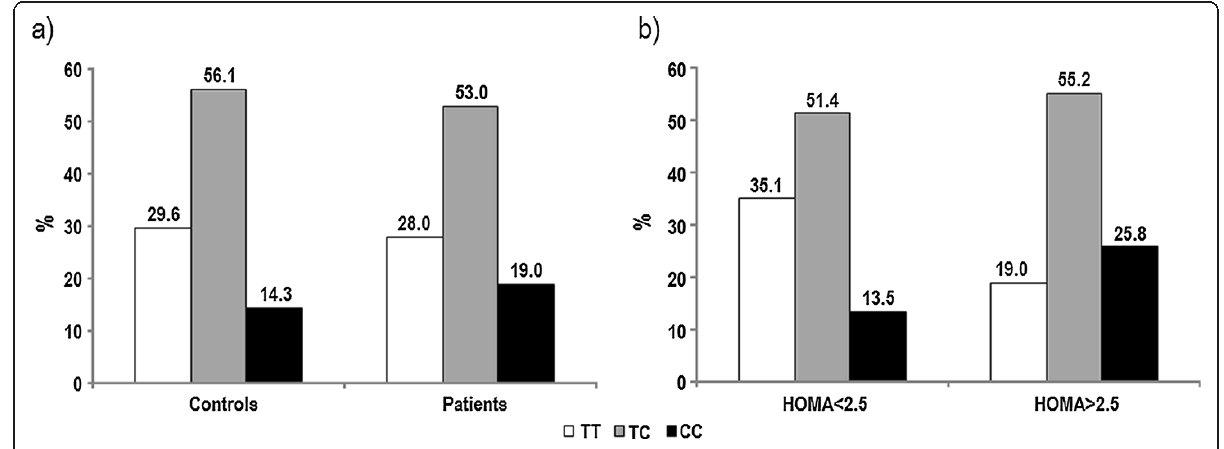
Figure 1 Genotype frequencies for the polymorphism of eNOS gene promoter T − 786 → C a) in healthy subjects and patients with systolic LV dysfunction and b) in patients with HOMA - IR index < 2 . 5 or with HOMA - IR > 2 .